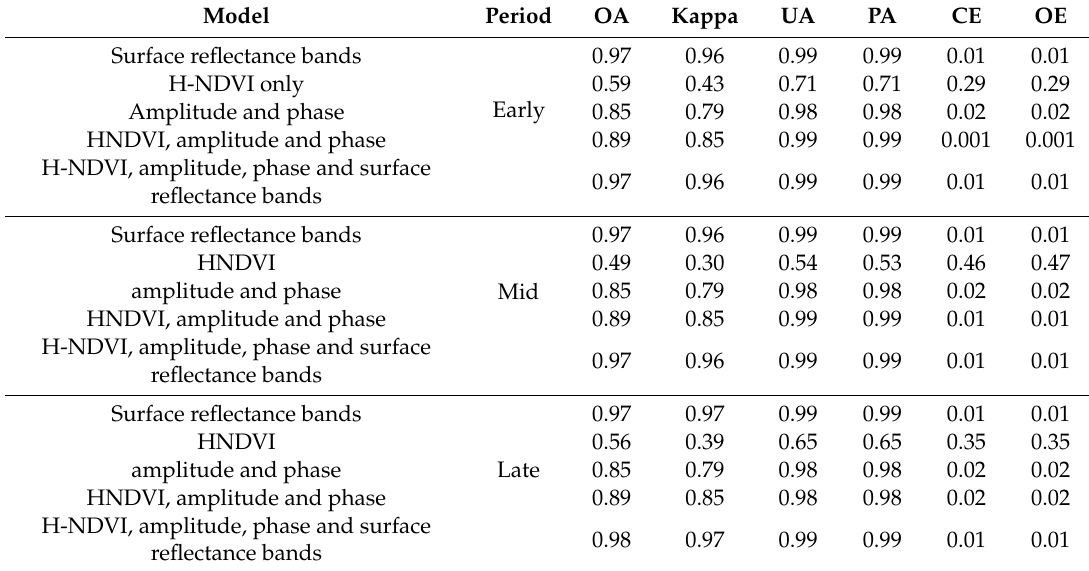
Table 2. Lists of overall Accuracy (OA), kappa, User’s Accuracy (UA), Producer’s Accuracy (PA) accuracies, and Omission Error (OE) and Commission errors (CE) achieved from random sampling based Random Forest (RF) classification applied to the validation datasets.